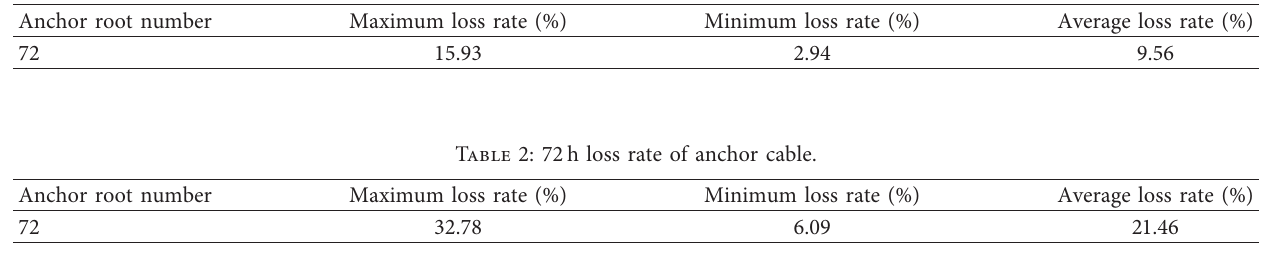
Table 1: 24h loss rate of anchor cable.